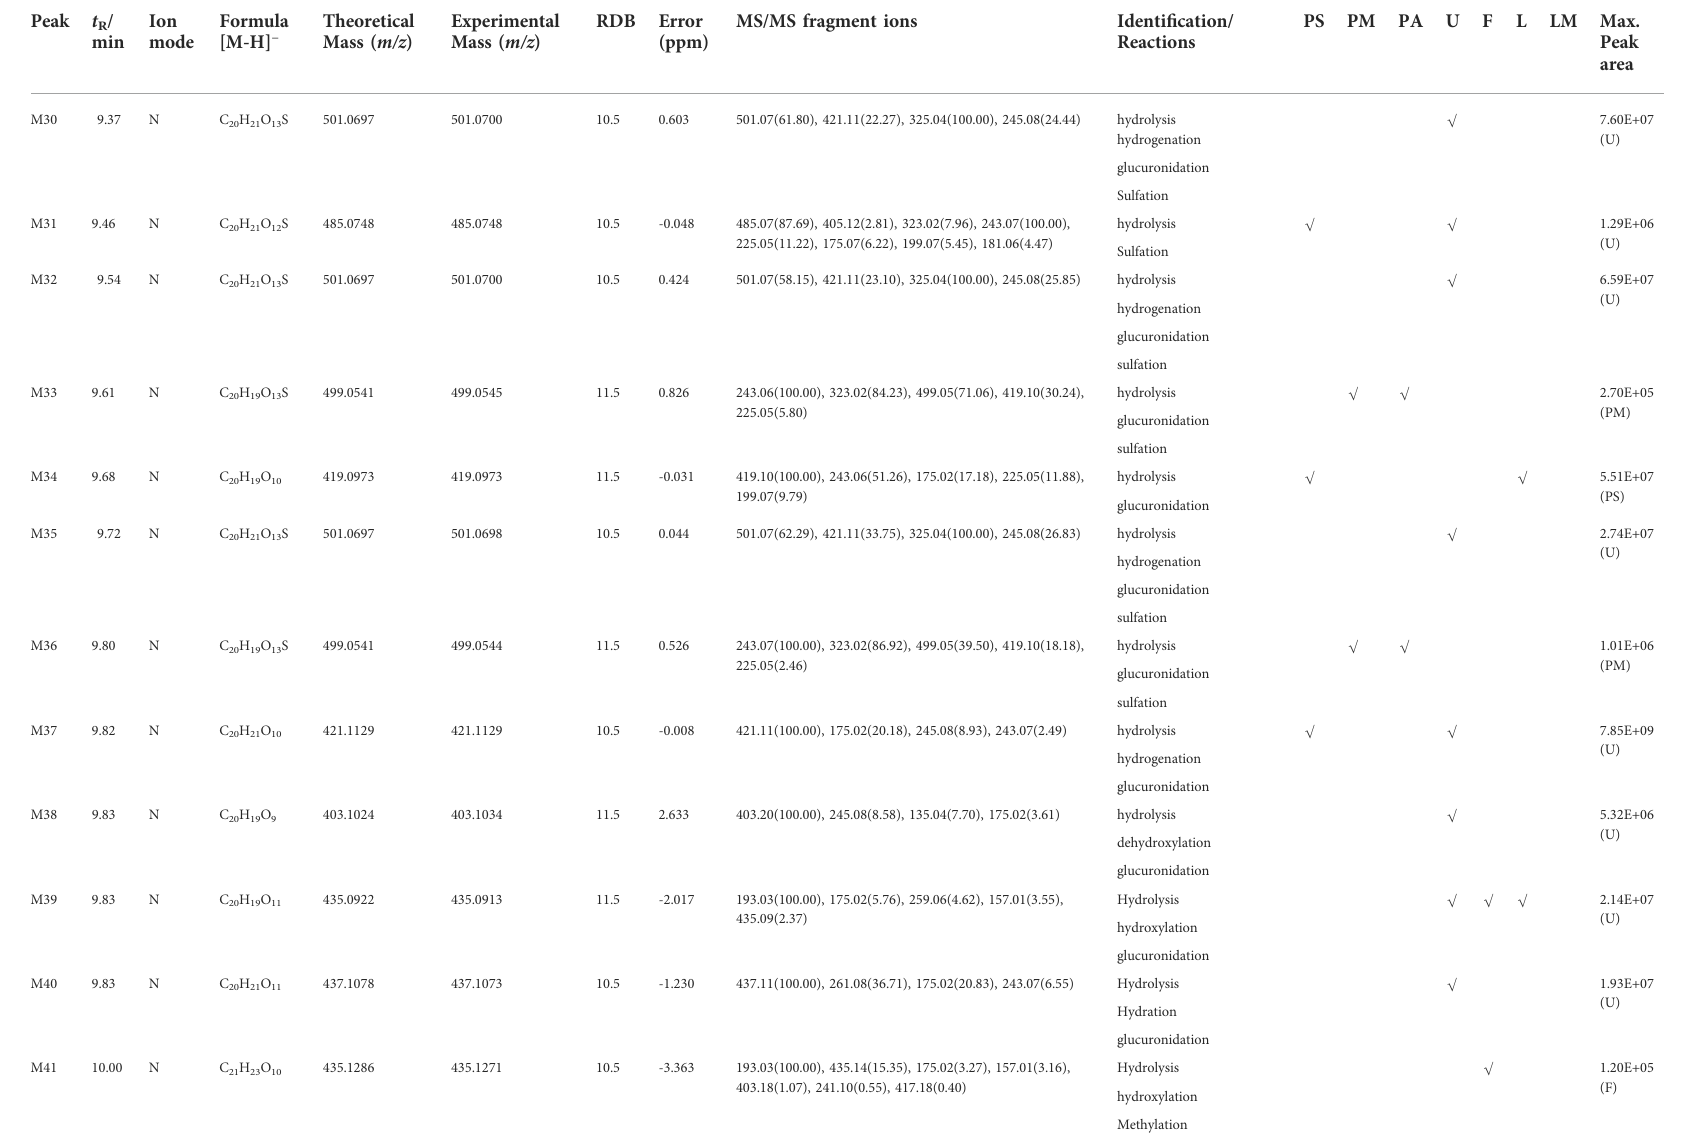
TABLE 1 ( Continued ) Summary of mulberroside A metabolites in vivo and in vitro of